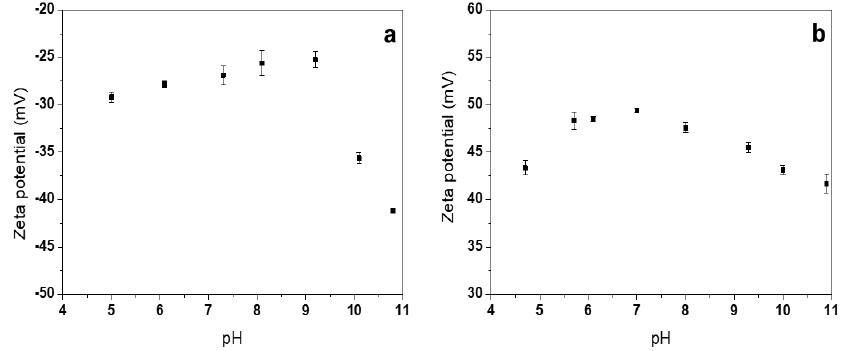
Figure 6. ζ-potential measurements as a function of pH: ( a ) calcined (450 °C) ZnO-BAC nanostructures; ( b ) dried (120 °C) ZnO-PDDA nanostructures.